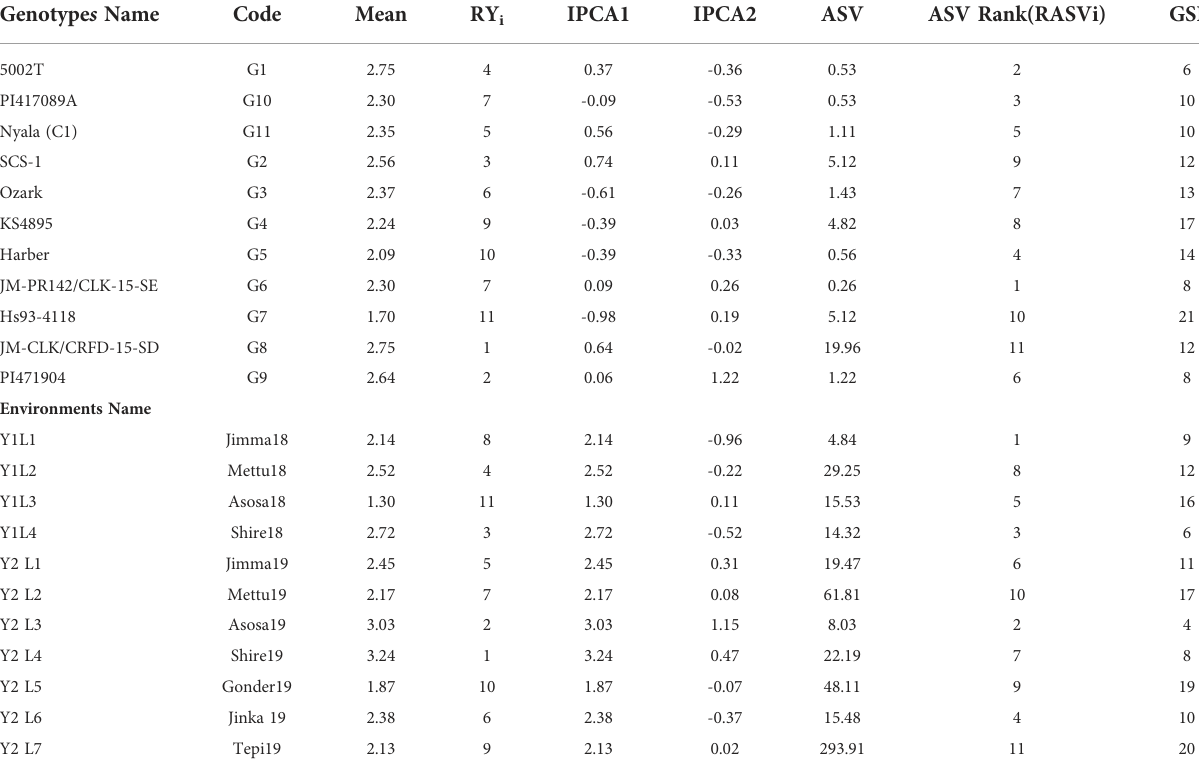
TABLE 5 Average grain yield, IPCA score, ASV and GSI Soybean genotypes across